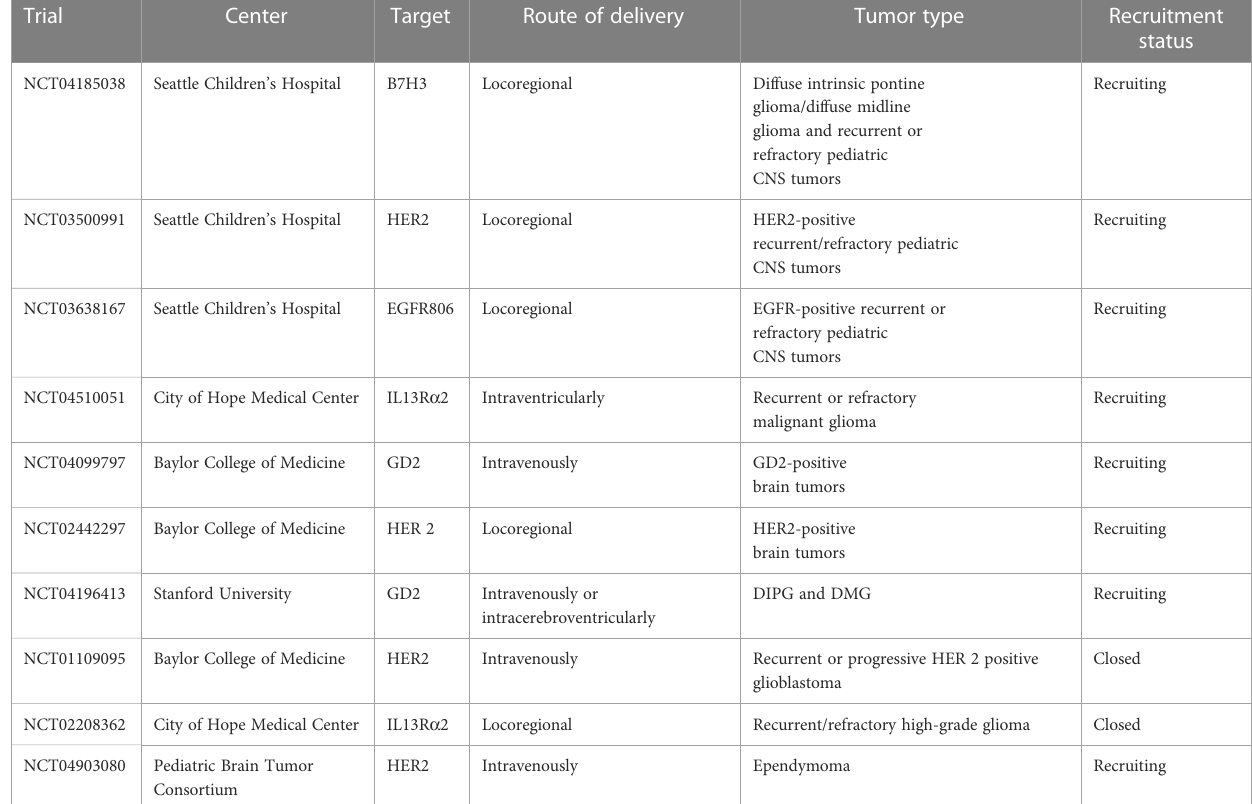
TABLE 1 Overview on CAR-T cells clinical trial for pediatric brain